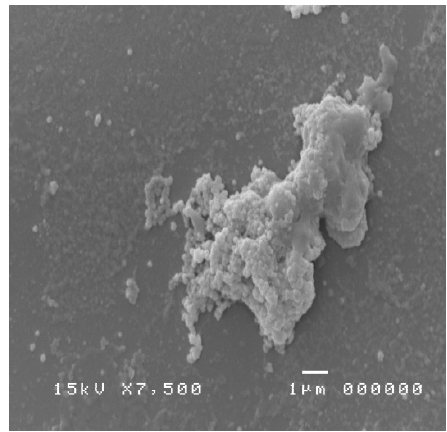
Figure 4. SEM image showing a mycoplasma colony (image enlargement 10,000 × ).